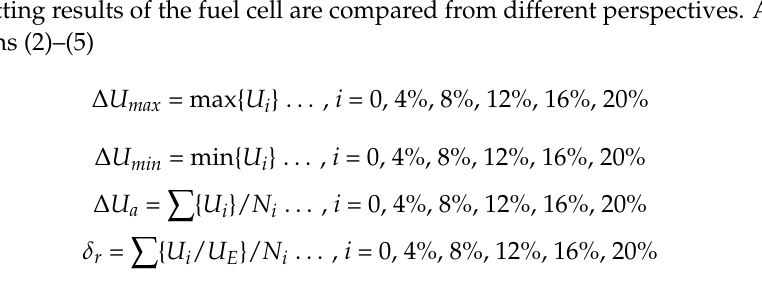
Figure 11. Error analysis of cell 4 with different nitrogen concentrations at different current densities: ( a ) 0.2 A · cm − 2 ; ( b ) 0.6 A · cm − 2 ; ( c ) 1.0 A · cm − 2 ; ( d ) 1.4 A · cm − 2 .